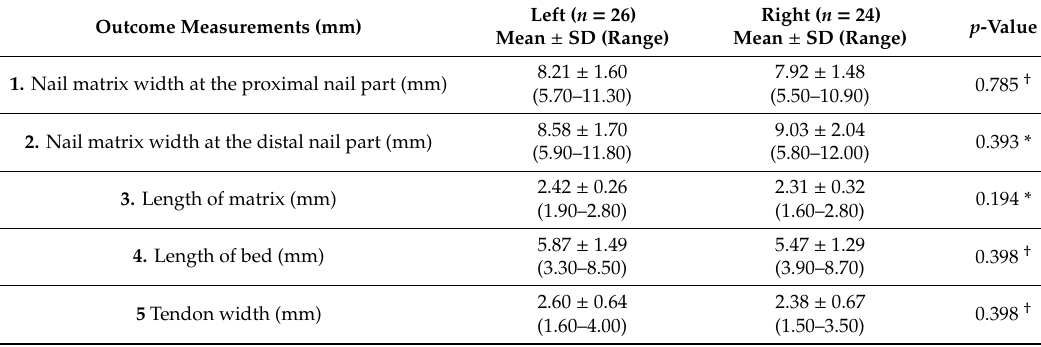
Table 3. Lower limb side di ff erences for dimensions of the matrix, bed and EDL tendon of the second toes ( n =